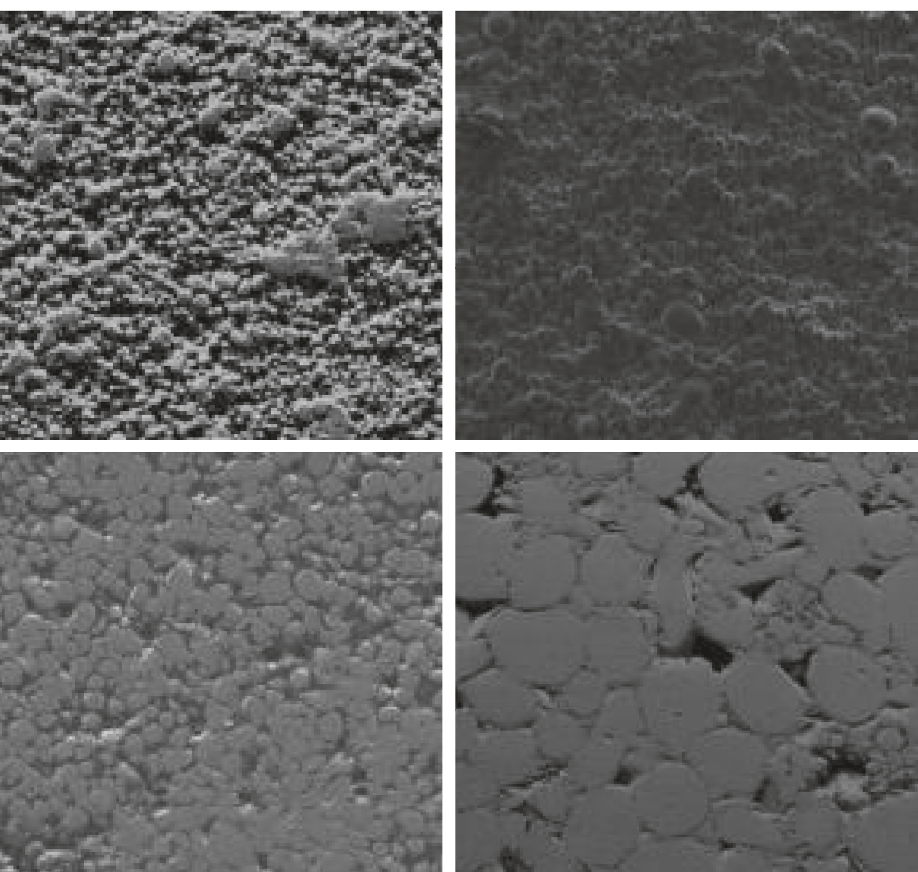
Figure 7: Powder metallurgy